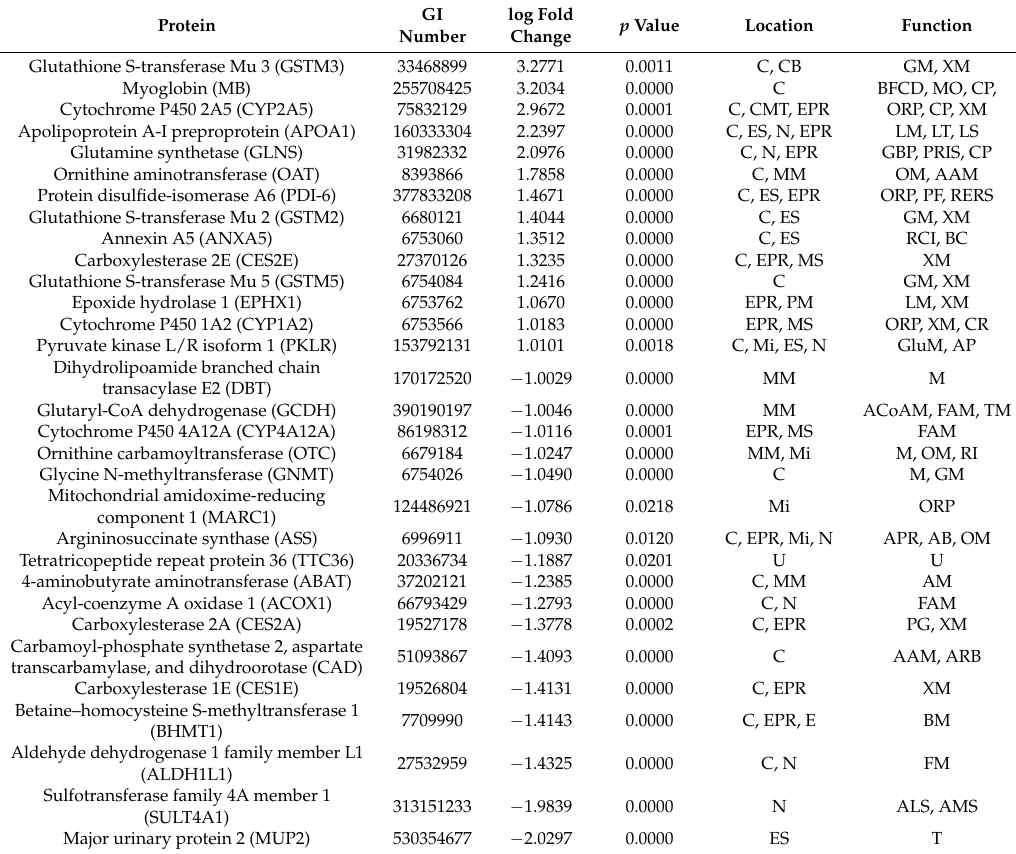
Table 3. Differentially-expressed proteins in the liver tumors of TSOD mice detected by QSTAR Elite